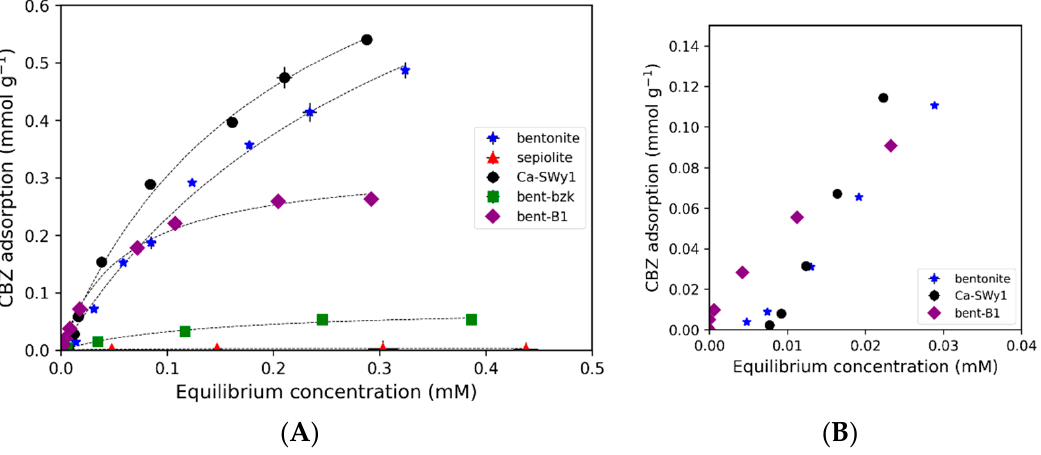
Figure 1. Adsorption isotherms of ( A ) carbamazepine on bentonite (blue asterisk), sepiolite (red triangle), Ca-SWy1 (black circle), bent-bzk (green square), and bent-B1 (purple diamond). Error bars represent triplicate standard deviations. The dashed lines represent Langmuir model predictions according to the estimated parameters detailed in Table 2. ( B ) Isotherms at low concentration of carbamazepine on bentonite, Ca-SWy1, and bent-B1. Table 2. Langmuir and Sips equations’ parameters for carbamazepine adsorption on clays and or- ganoclays.